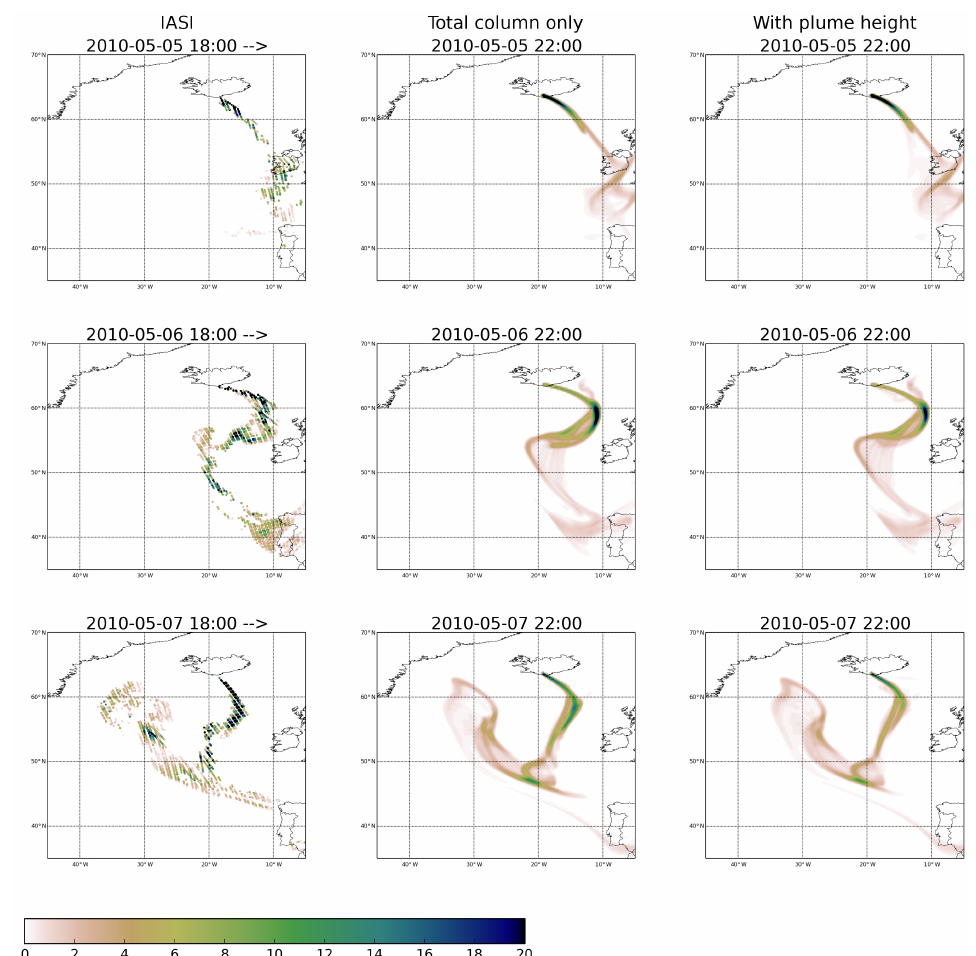
Figure 9. SO 2 column loading (DU) for the IASI column retrievals (left column), for the a posteriori simulation with assimilation of total column only (middle) and with assimilation of total column and plume height retrievals. Results for 5, 6 and 7 May 2010 are shown in the rows from top to bottom. The evening overpasses are shown for IASI; the model fields are valid at